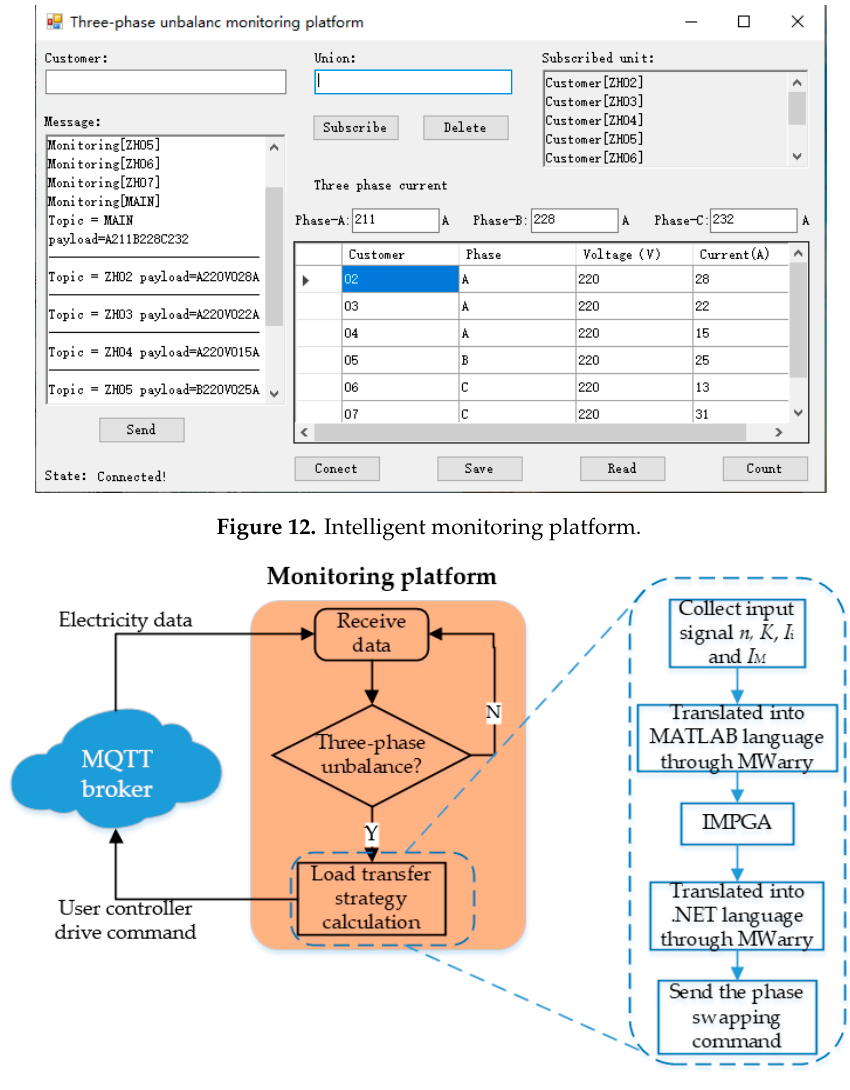
Figure 13. The workflow of the platform.